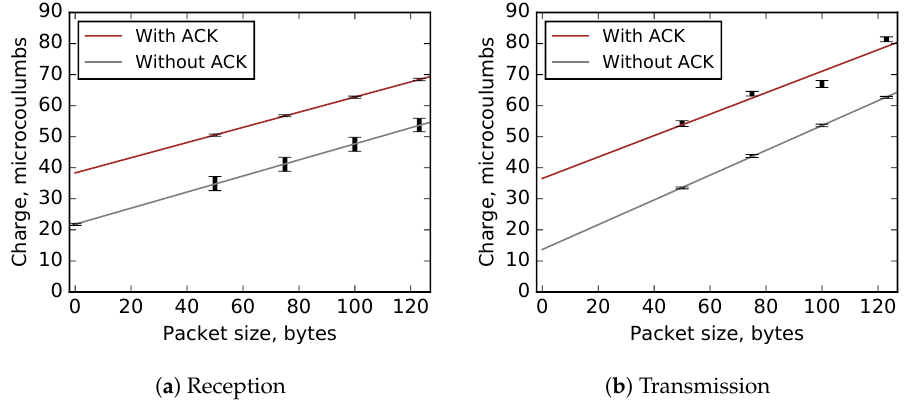
Figure 5. TSCH timeslot charge consumption profiles: measurements and the regression line. The bars show the minimal/maximal measurement range.